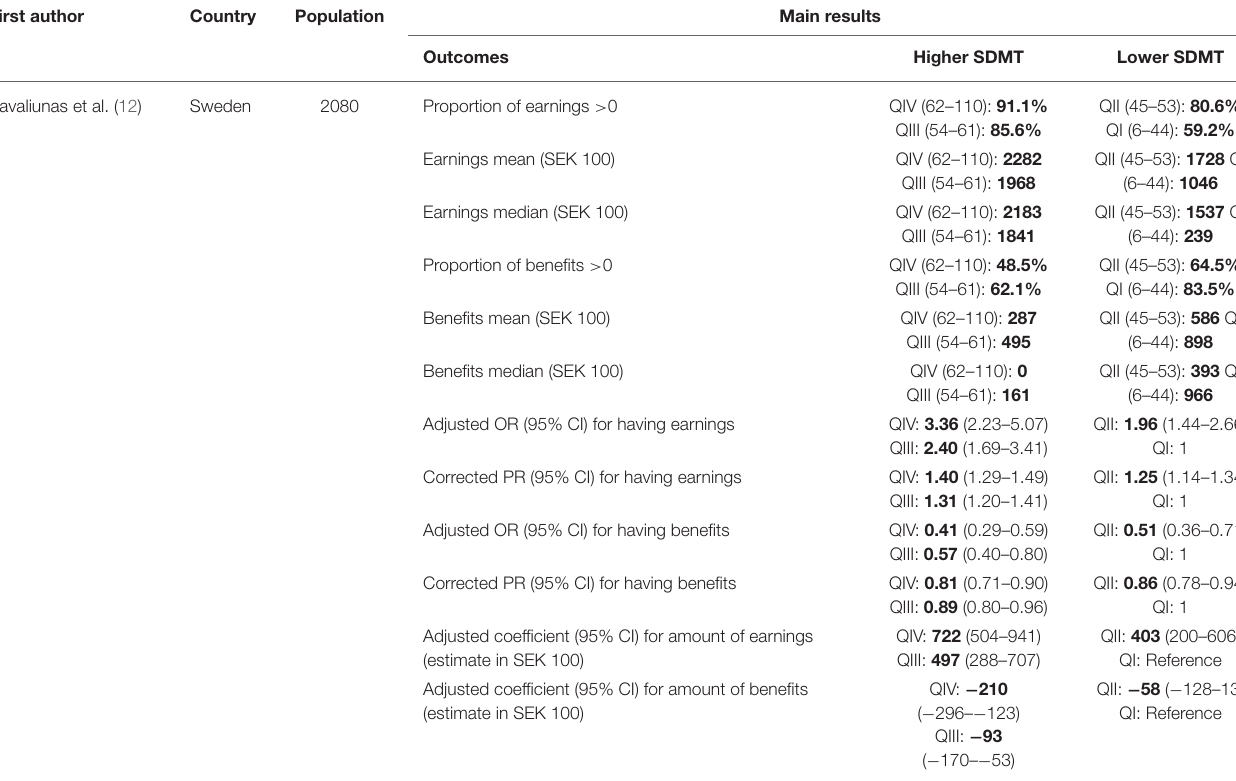
TABLE 5 | Studies that investigated income-related outcomes in patients with MS within different levels of cognitive